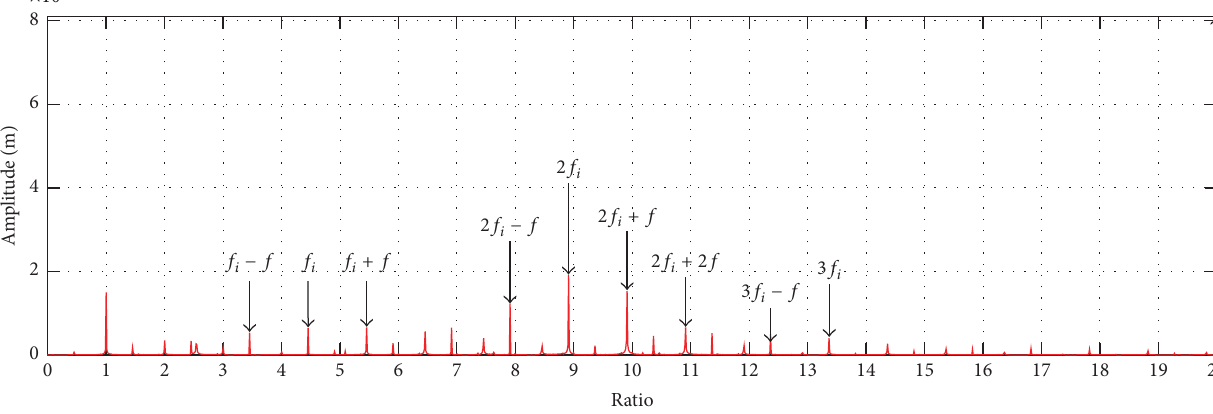
Figure 14: The spectral diagram of the faulted system with SFD mounted on the faulted bearing at 𝜔 = 100 rad/s.